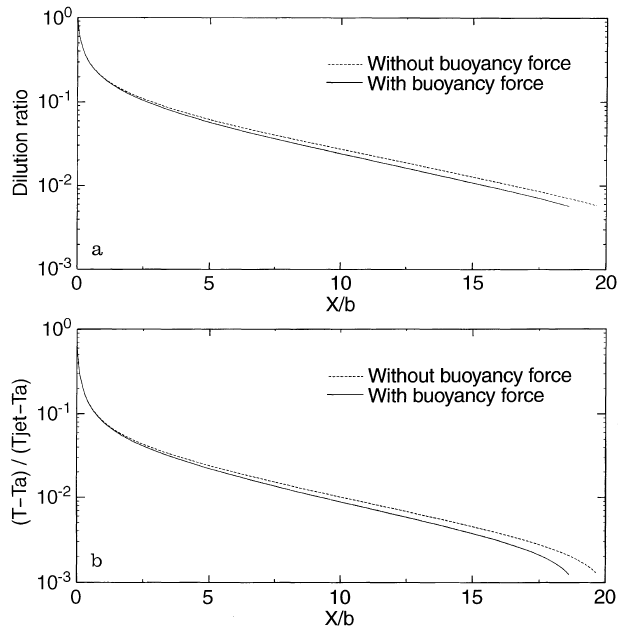
Fig. 5. E(cid:128)ect of the buoyancy force on a the dilution ratio and b normalised mean temperature, plotted versus x / b (b being the span) for a twin-engine Airbus 330. This calculation is carried out using the integral model (Tjet is the jet temperature at the exit nozzle plan and Ta the ambient temperature)